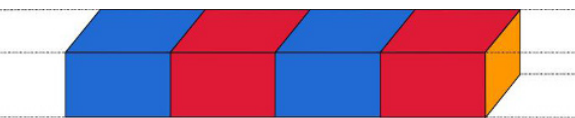
Fig. 1. Schematic diagram of one-dimensional electromagnetic field periodic system model. It is arranged periodically along the X direction. In the first half of the cycle, the placement meets the requirements electromagnetic medium; In the second half of the cycle, the placement meets electromagnetic medium. Light travels in a µ − ε = 0 µ + ε = 0